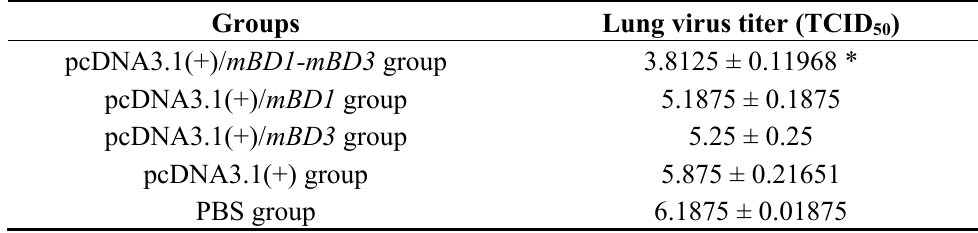
Table 3. Results of TCID titer measuring of lung homogenates (−log10, n = 50